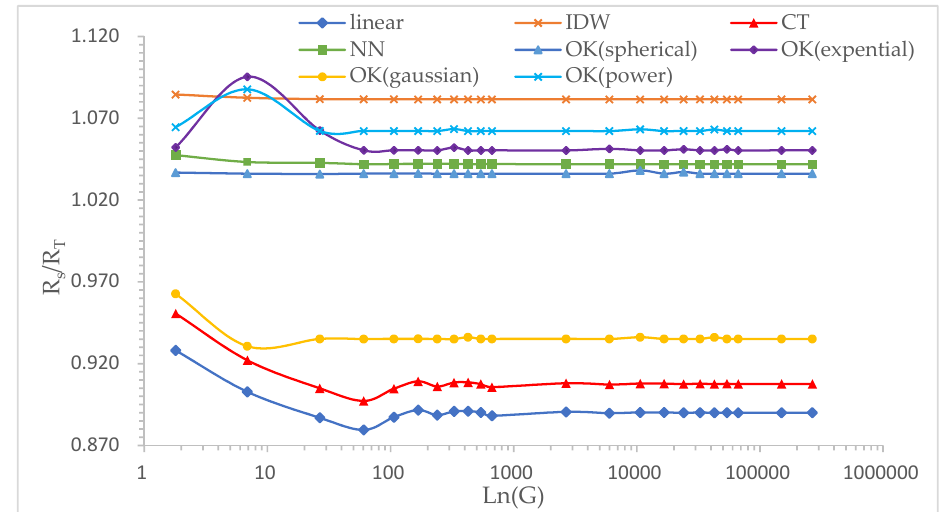
Figure 5. The relationship curve between R S /R T and Ln(G). Table 4. Relative error of uranium reserves.